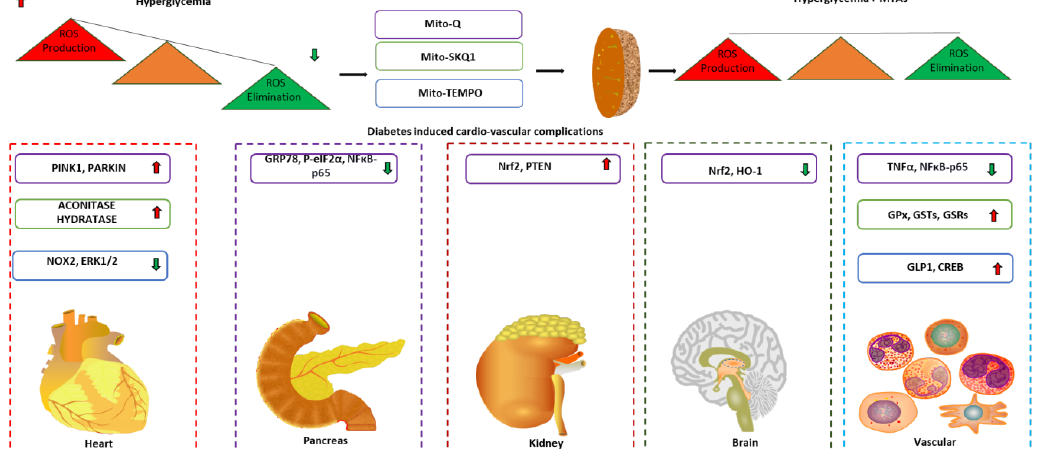
Figure 4. Potential application of mitochondrial targeted antioxidants in diabetic complications. Arrows indicate the direction of changes in the expression or function. MTA: Mitochondrial targeted antioxidants; PINK1: PTEN induced kinase 1; NOX2: NADPH oxidase 2; ERK1/2: Extracellular signal-regulated protein kinase 1/2; GRP78: Glucose related protein 78; NF κ B: Nuclear factor kappa B; Nrf2: Nuclear factor erythroid 2–related factor 2; PTEN: Phosphatase and tensin homolog;